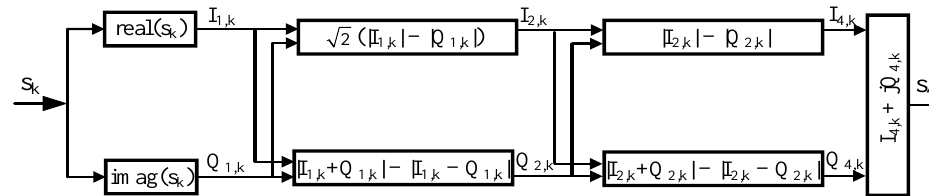
Figure 2. Block diagram of the signal-preprocessing stage.